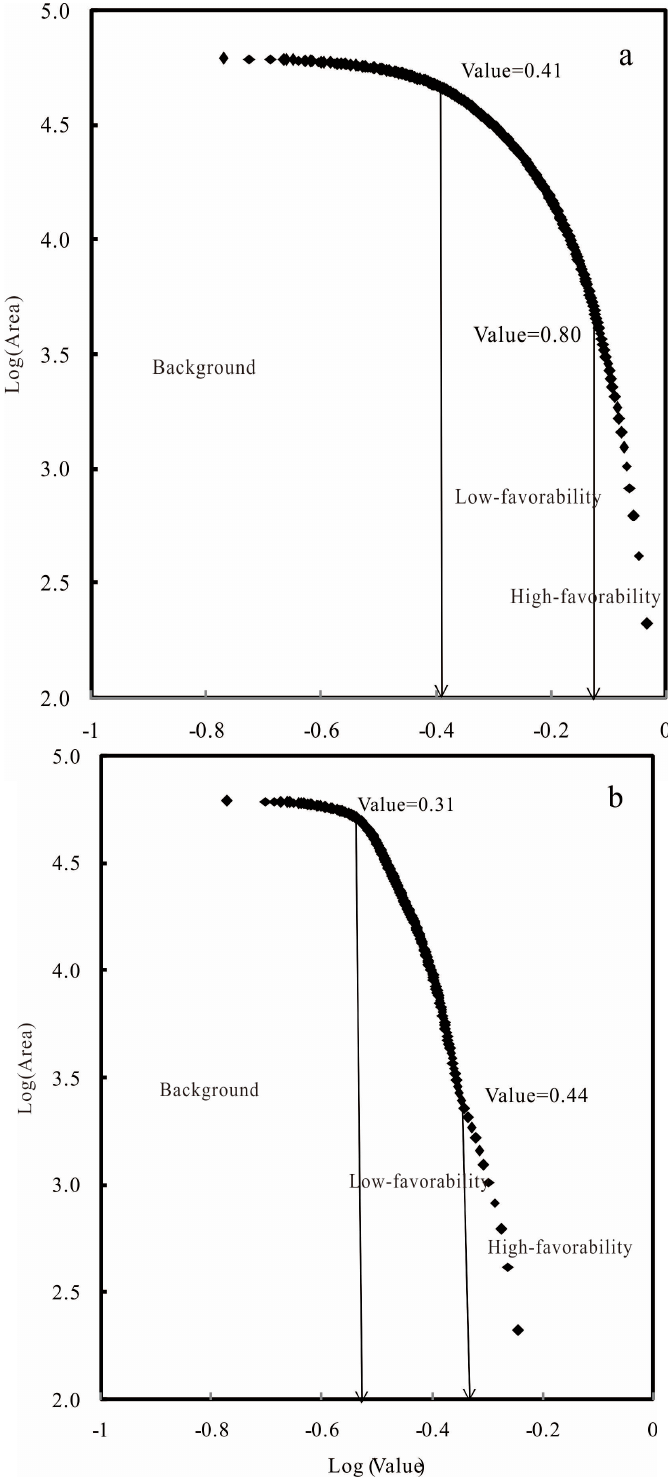
Figure 7. Concentration-area (C-A) model for the prospectivity map. ( a ) Based on fuzzy logic, ( b ) Based on fuzzy AHP. Value = 0.44.